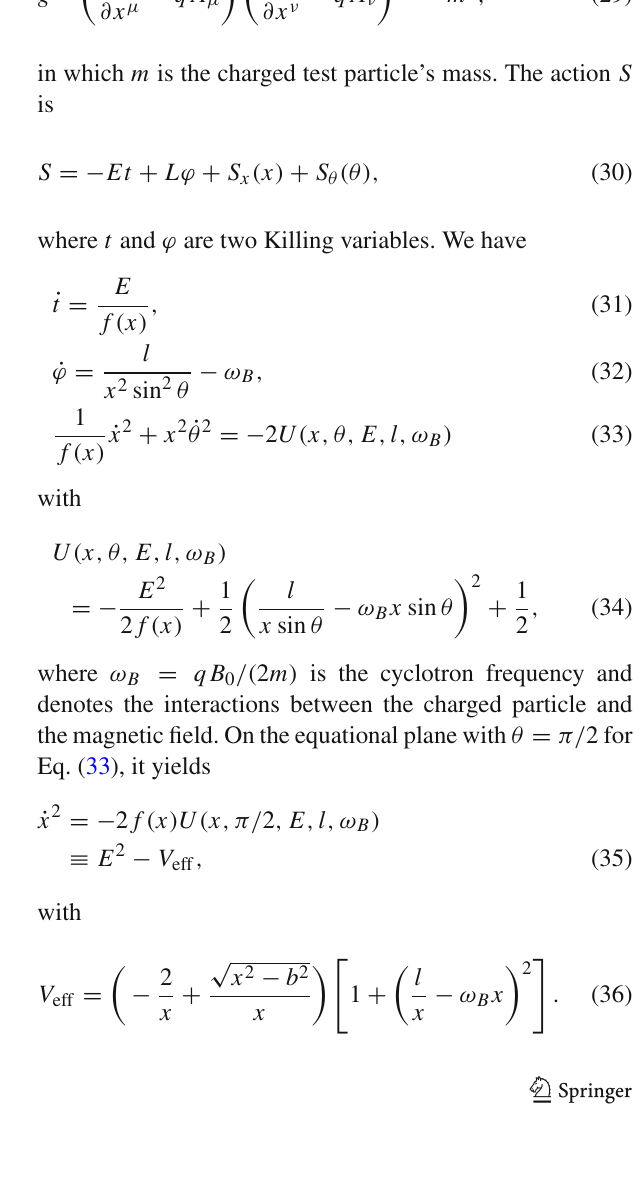
Fig. 4 The azimuthal component of the external magnetic field B normalized to its asymptotic value B 0 with respect to x